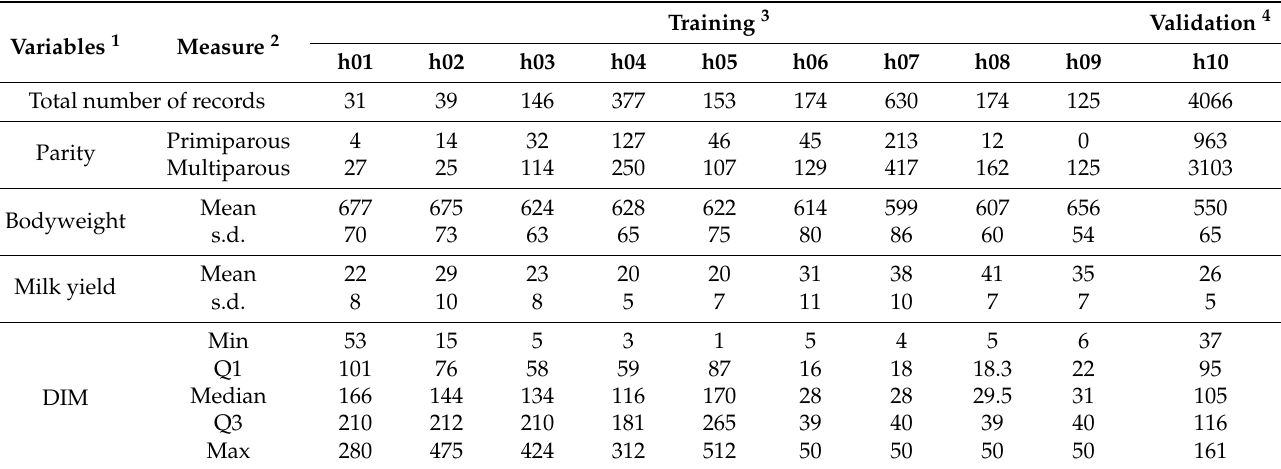
Table 2. Descriptive statistics of training and validation